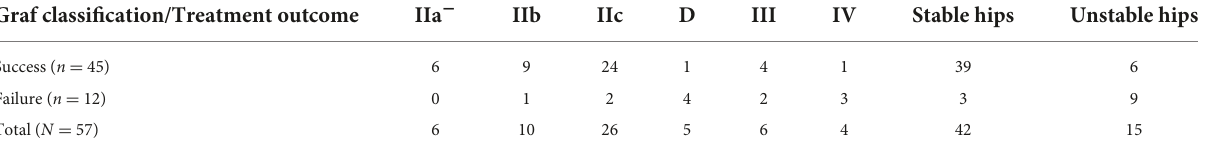
TABLE 3 Treatment success and failures according to severity of DDH according to Graf classification (19). Graf classification/Treatment